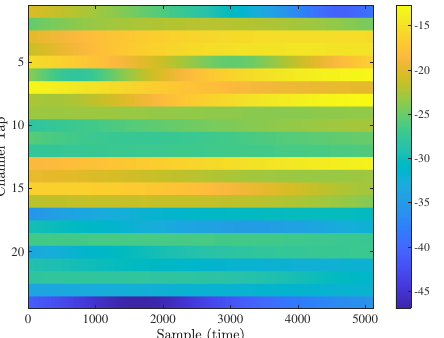
Figure 2. The 2 time − varying channel profile with f d = 200 Hz in the 20 OFDM